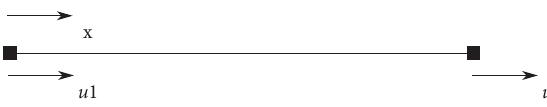
Figure 3: Linear truss element with nodal degrees of freedom,